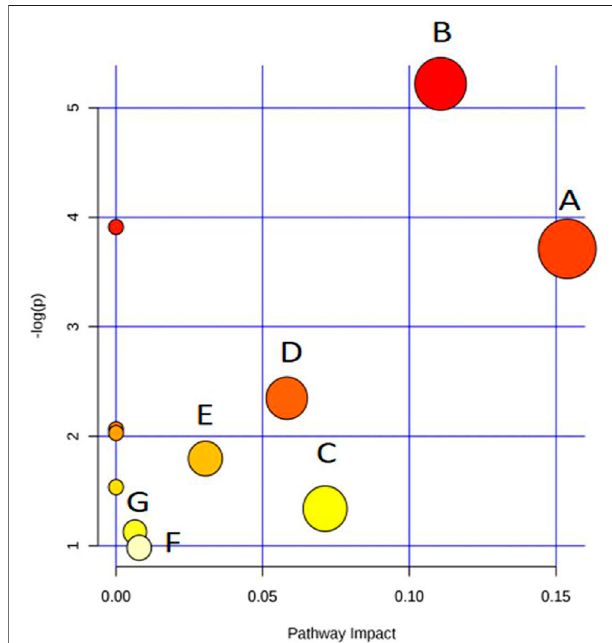
FIGURE 3 | Overview of pathway analysis (A) glyoxylate and dicarboxylate metabolism, (B) tyrosine metabolism, (C) pyrimidine metabolism, (D) tricarboxylic acid (TCA) cycle, (E) ubiquinone and other terpenoid-quinone biosynthesis, (F) purine metabolism, and (G) arginine and proline